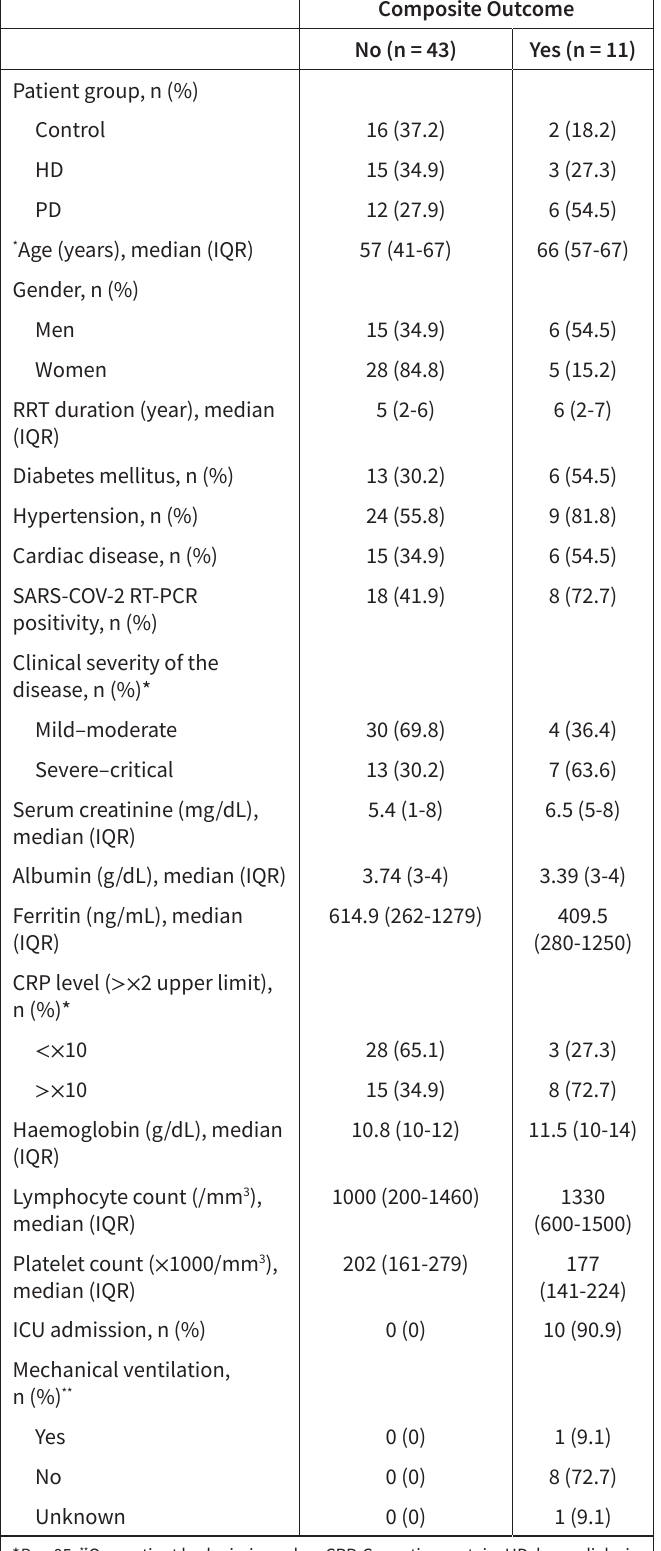
Table 3. The Data of the Patient According to the Composite